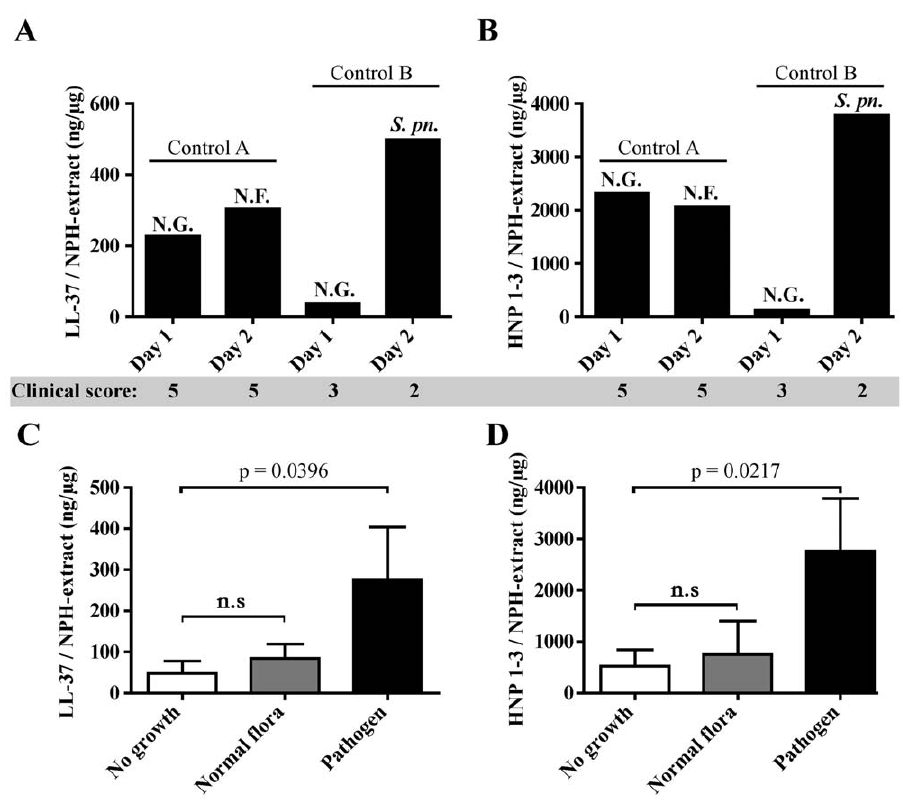
Figure 2. AMP response in nasal fluid of healthy controls. Two previously healthy controls (A, female, age 36; B, male, age 38) were sampled for nasal fluid on two consecutive days and AMP levels were determined. The total levels of LL-37 (A) and HNP1–3 (B) are expressed as nanogram peptide/total nasal fluid extract ( m g). The clinical score prior to sampling was also measured (A and B). The whole group of controls (both healthy and infected controls as determined by the clinical score) was analyzed for levels of LL-37 (n=18) (C) and HNP1–3 (n=12) (D). The number of samples (no growth, normal flora, pathogen, respectively) are n=7, 8, and 3 (C), n=7, 3, and 2 (D). Error bars depict the SEM of the samples (C and D).